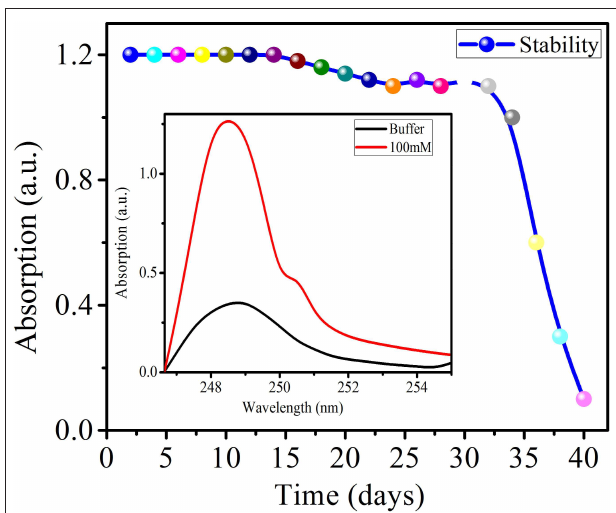
FIGURE 6 | Sensing response of developed biosensor.